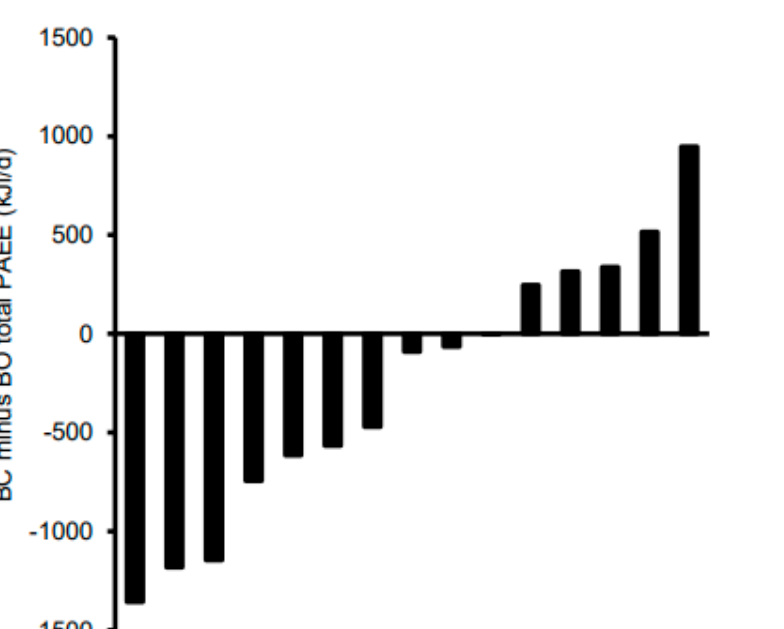
Figure 2. Individual total daily physical activity energy expenditure (PAEE) responses of adolescent girls who participated in the randomised crossover trial comparing seven days of breakfast consumption (BC) with seven days of breakfast omission (BO). BC was the consumption of a standardised breakfast with an energy content equivalent to 25% of individual resting metabolic rate before 09:00 for seven consecutive days; BO was the abstinence from all energy-providing nutrients until at least 10:30 for seven consecutive days.